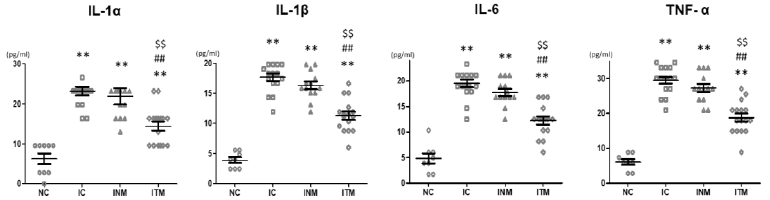
Figure 4. Reduced levels of inflammatory cytokines (IL-1 α , IL-1 β , IL-6 and TNF- α ) in the CSF observed in the rats with severe IVH after transplantation with thrombin-preconditioned MSCs ( n = 8, 16, 13 and 16 in the NC group, IC group, INM group and ITM group, respectively). Data are expressed as means ± SEM. ** p < 0.01 compared with the NC group, ## p < 0.01 compared with the IC group, $$ p < 0.01 compared with the treatment with naïve Wharton’s jelly-derived MSCs group. NC, normal control; IC, IVH control; INM, IVH with transplantation of naïve MSCs; ITM, IVH with transplantation of thrombin-preconditioned MSCs; IL, interleukin; TNF, tumor necrosis factor; CSF, cerebrospinal fluid; IVH, intraventricular hemorrhage; MSCs, mesenchymal stem cells; SEM, standard error of the mean.